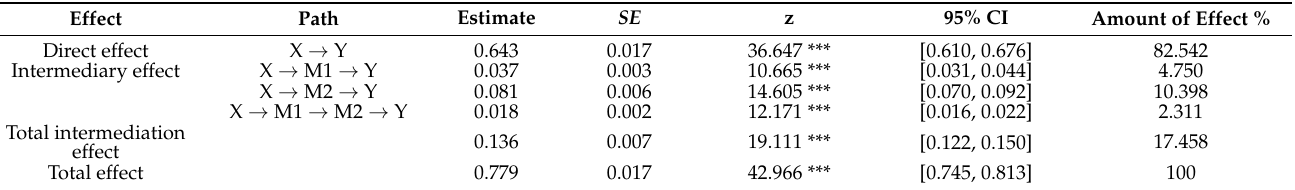
Table 2. Analysis of the mediating effects of social equity and social trust between subjective socioeconomic status and life